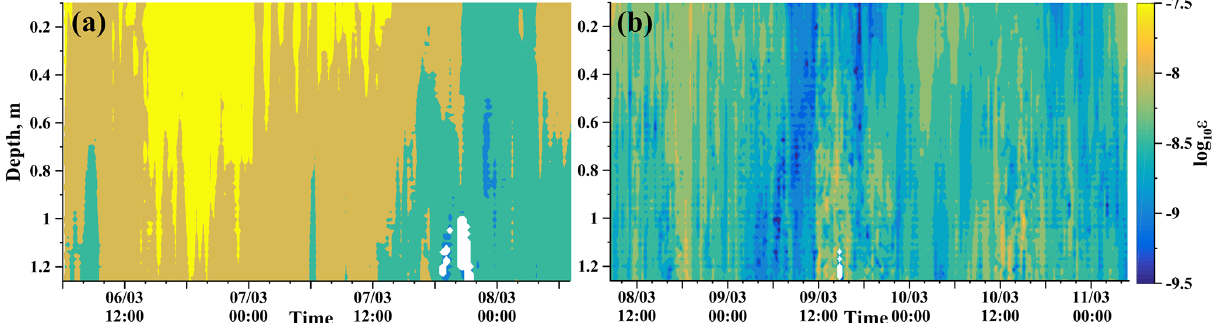
Figure 7. The TKE dissipation rates in the area of the jet stream (station S1, a ) and in the region of weak currents (station S2, b ).